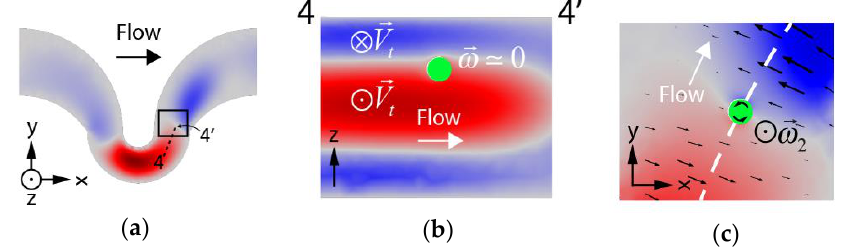
Figure 14. Transverse velocity magnitude and sense of the flow in the x-y plane. ( a ) General view of the channel with marked cross sections; ( b ) The interface between the outward- and inward-moving flow is no longer distorted so no modification of the angular velocity vector is produced in this region; ( c ) A strong induced angular velocity (ω 2 , with positive z direction) is observed at the vicinity of the transverse inwards-outwards transition region.